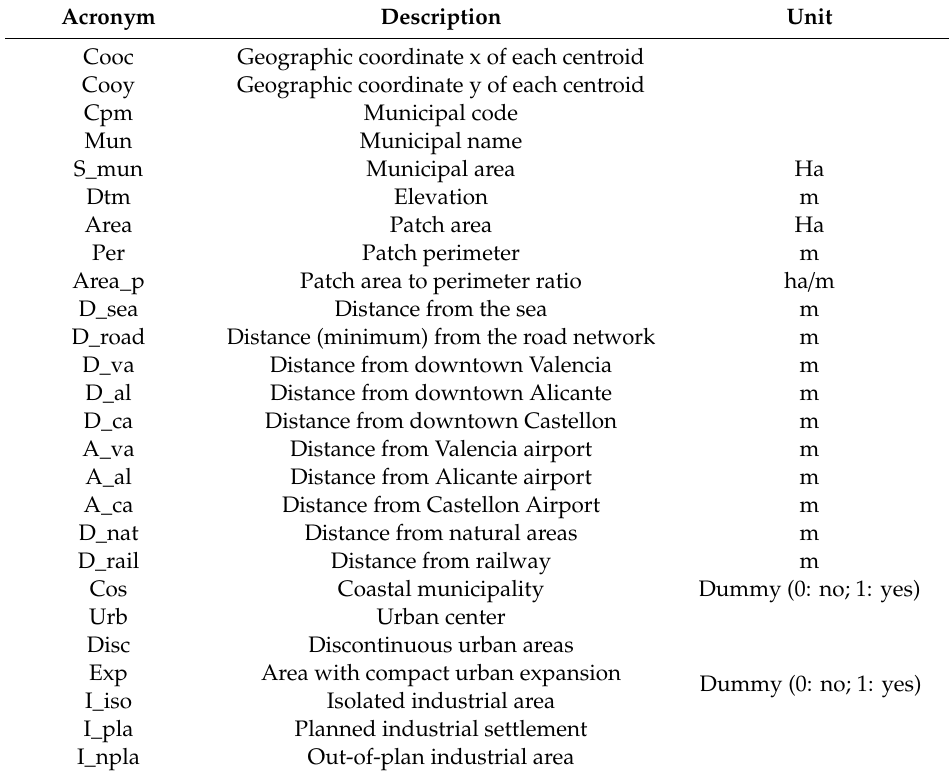
Table 1. List of indicators used in this